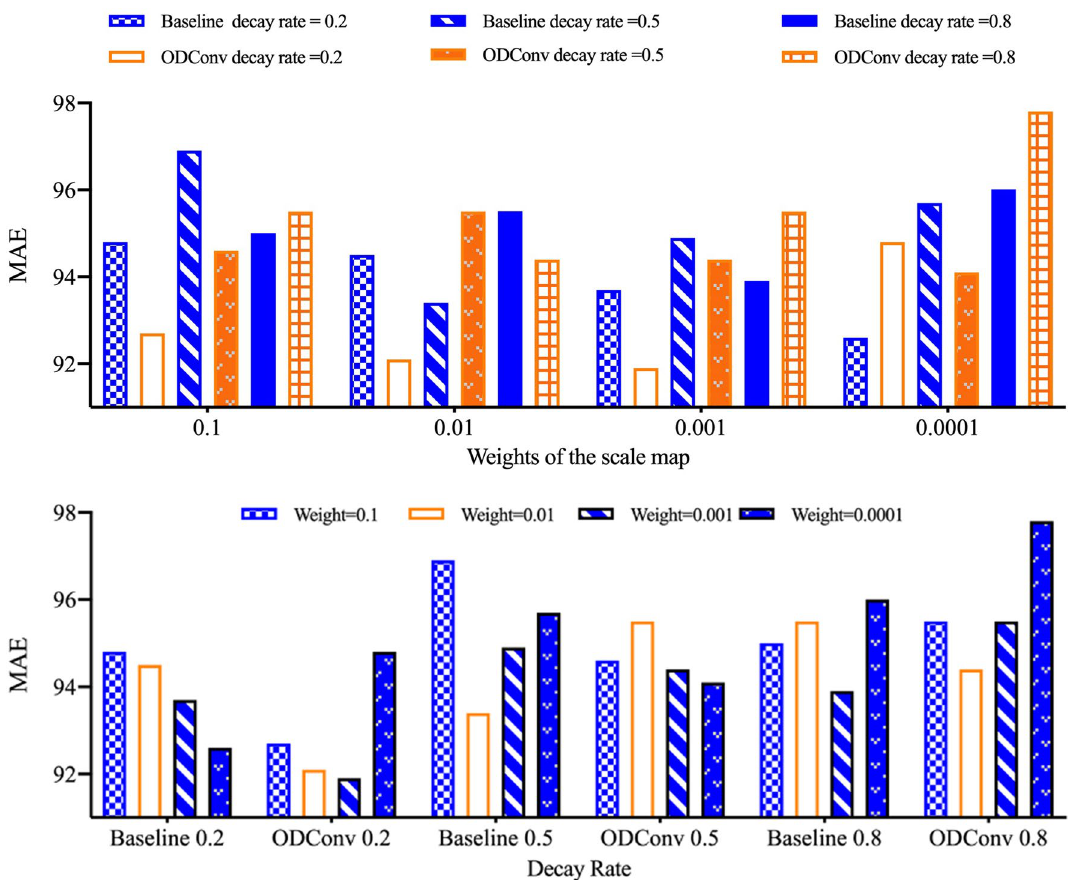
Figure 8. The comparisons of DConv and our ODConv with different weights of the scale map and decay rates.